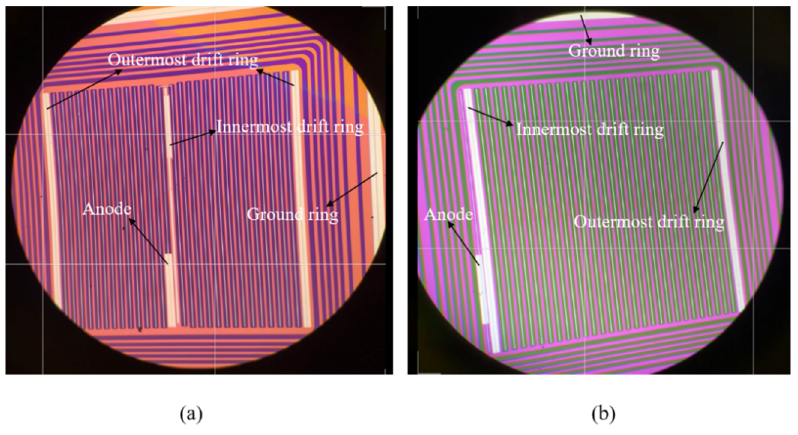
Figure 1. ( a , b ) The optical image of the fabricated two square-SDD devices SDD-1 and SDD-2. Metallic aluminum covers the surfaces of the anode, the innermost drift ring, the outermost drift ring, and the ground ring, respectively, for the applied voltage.